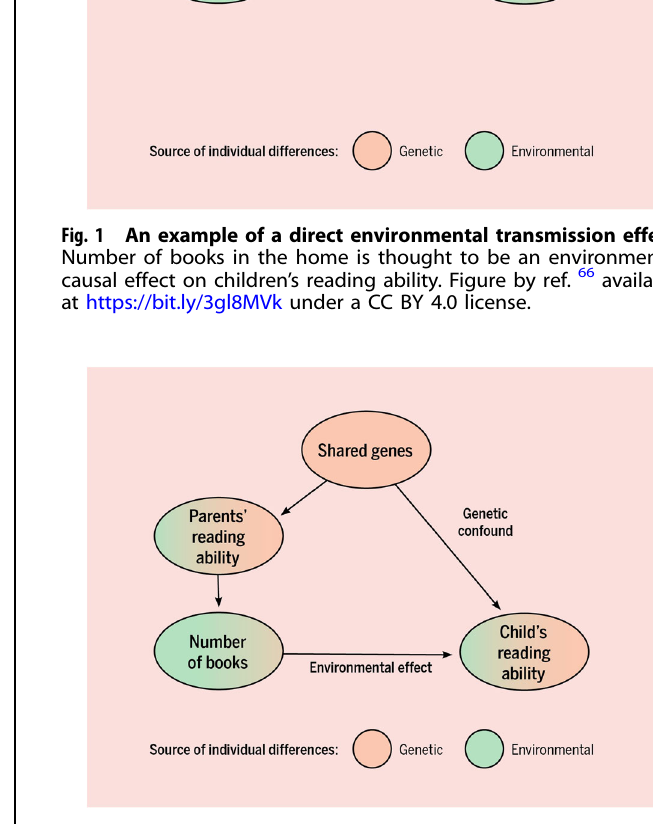
Fig. 2 An example of how genetic confounding works (note, only one parent drawn, for simplicity). Parents share genes related to reading ability with their children, and also control the number of books in their home. This creates gene – environment interplay. It is important to note that the environmental effect may still have a causal role, even with gene – environment interplay. If genes play a role but are not modeled (as in Fig. 1), the correlation between the environmental measure and the child ’ s trait is genetically con- founded. Here, the role of genes is modeled, allowing for an estimation of the genetic effect and the environmental effect. Figure by ref. 66 available at https://bit.ly/31c52z9 under a CC BY 4.0